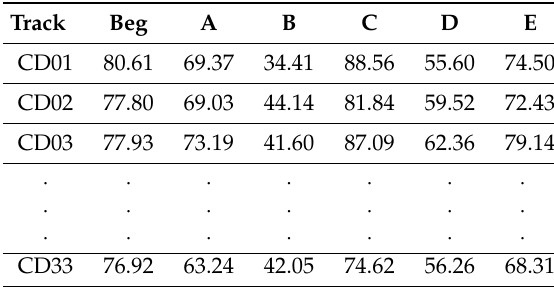
Table 1. The EAT of all motifs of the second database.